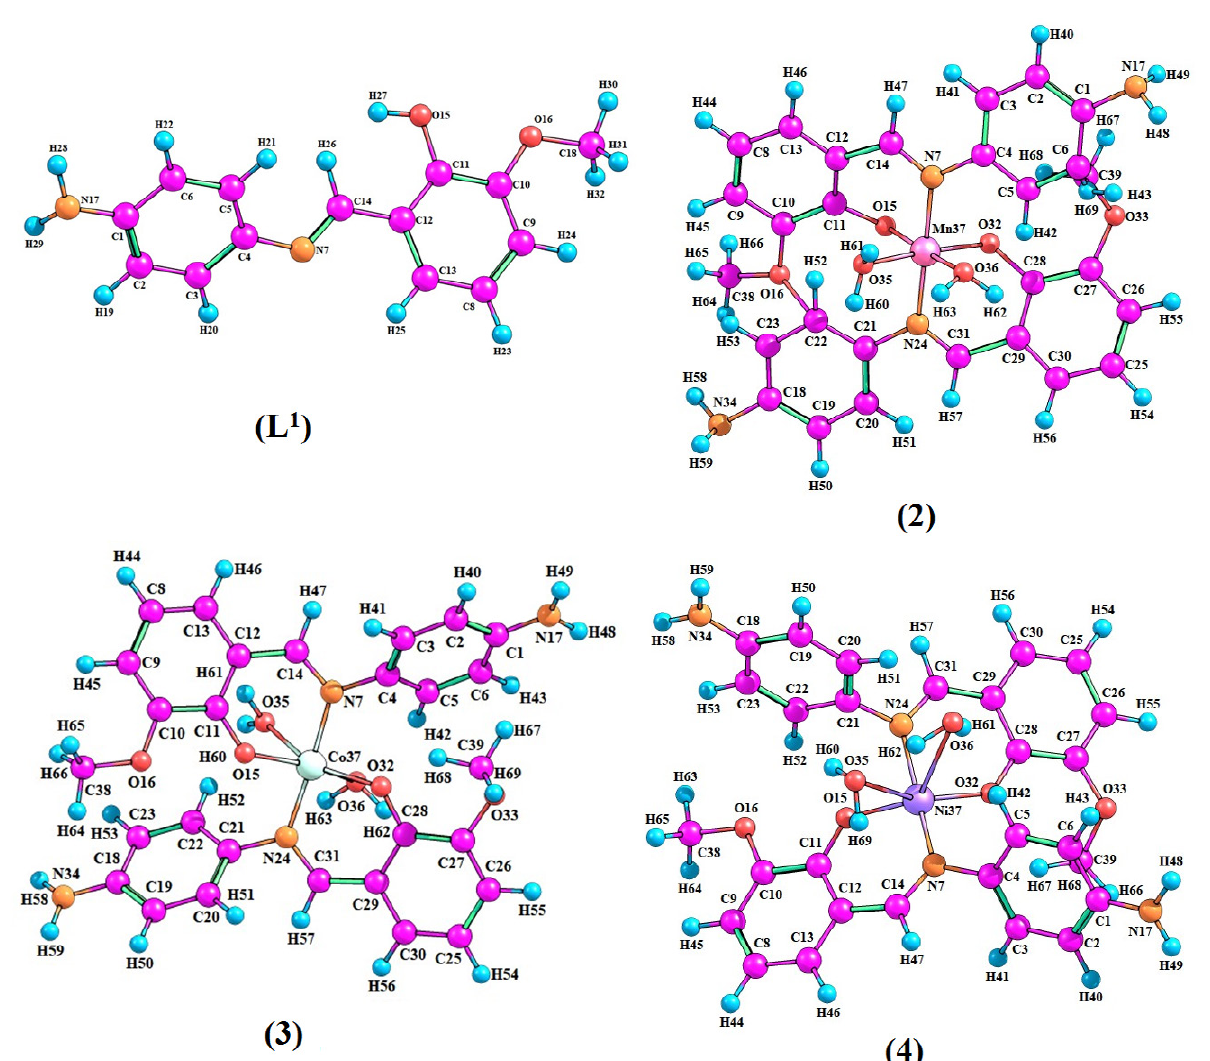
Figure 1. View of optimized geometrical structures of p -phenylenediamine ligand (L 1 ) and its derived metal complexes (2) , (3) and